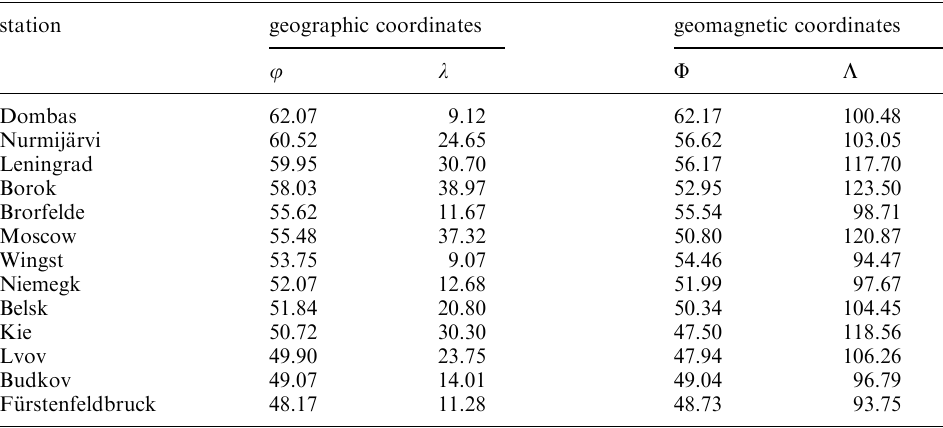
Table 3. Mid-latitude stations station geographic coordinates geomagnetic coordinates